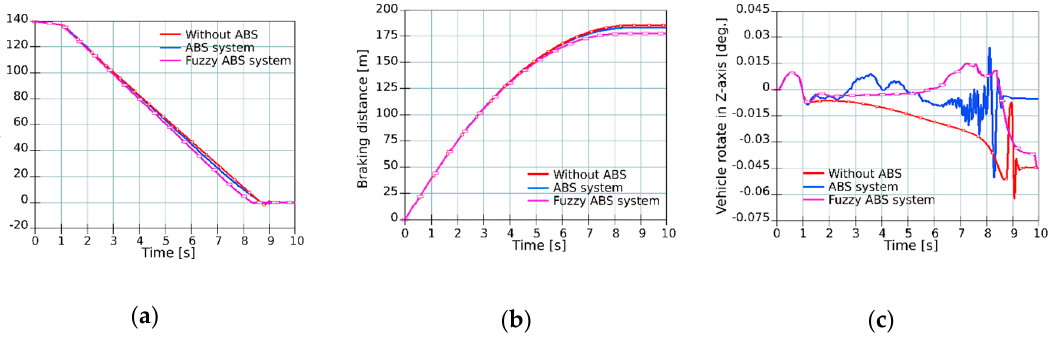
Figure 11. Test on dry road at speed 140 km / h—( a ) Speed curve; ( b ) Braking distance; ( c ) Vehicle rotation. Table 4. Test results on dry road at speed 140 km / h.